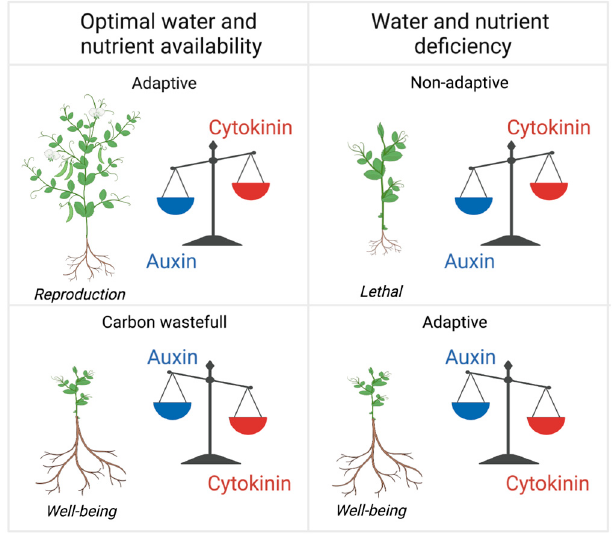
Figure 1. The auxin/cytokinin ratio and water and nutrient availability. Under optimal water and nutrient availability, auxin action decreases with a concomitant increase in cytokinin action, which increases the shoot/root growth ratio and leads to reproduction. A high auxin/cytokinin ratio would be suboptimal under these conditions, as it would lead to the needless allocation of carbon to root growth. Under water and nutrient deficiency conditions, auxin action is increased and cytokinin action is decreased, which ensures plant survival and reproduction, albeit at a lower rate. A high cytokinin/auxin ratio would be lethal under these conditions; vigorous shoot growth would cause potentially deadly water loss, and the insufficient allocation of carbon flow to roots would impede an increase in root development needed to acquire adequate amounts of water and nutrients.